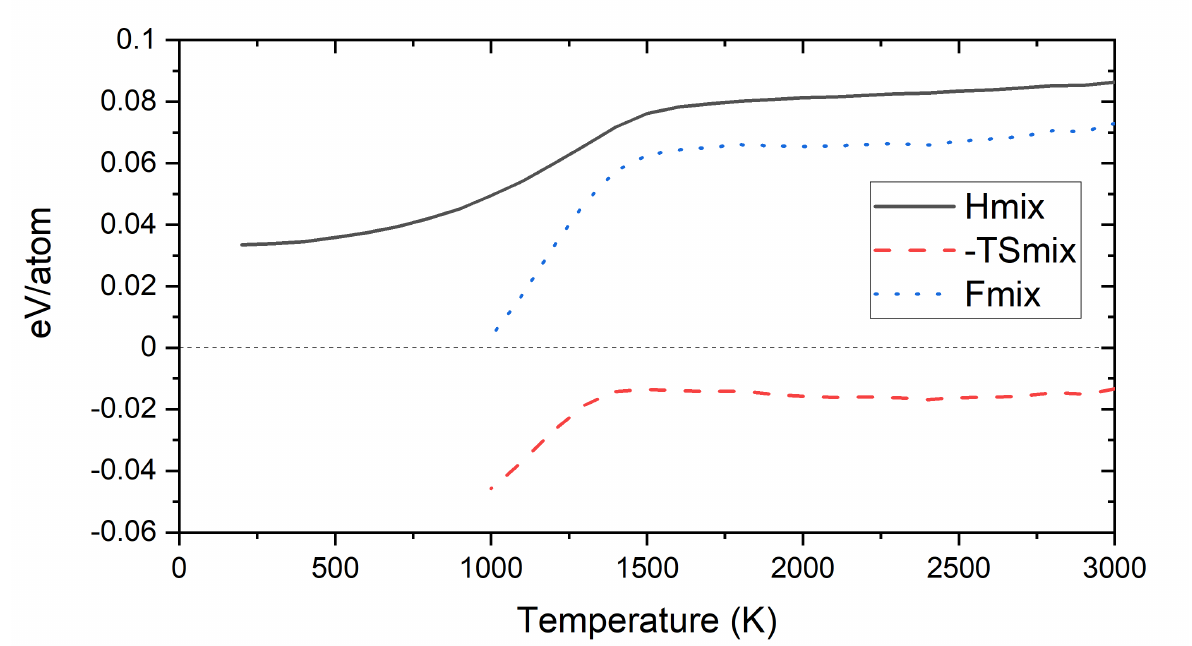
Figure 9. Free energy calculations from 1NN approximation for W 70 Cr 29 Y 1